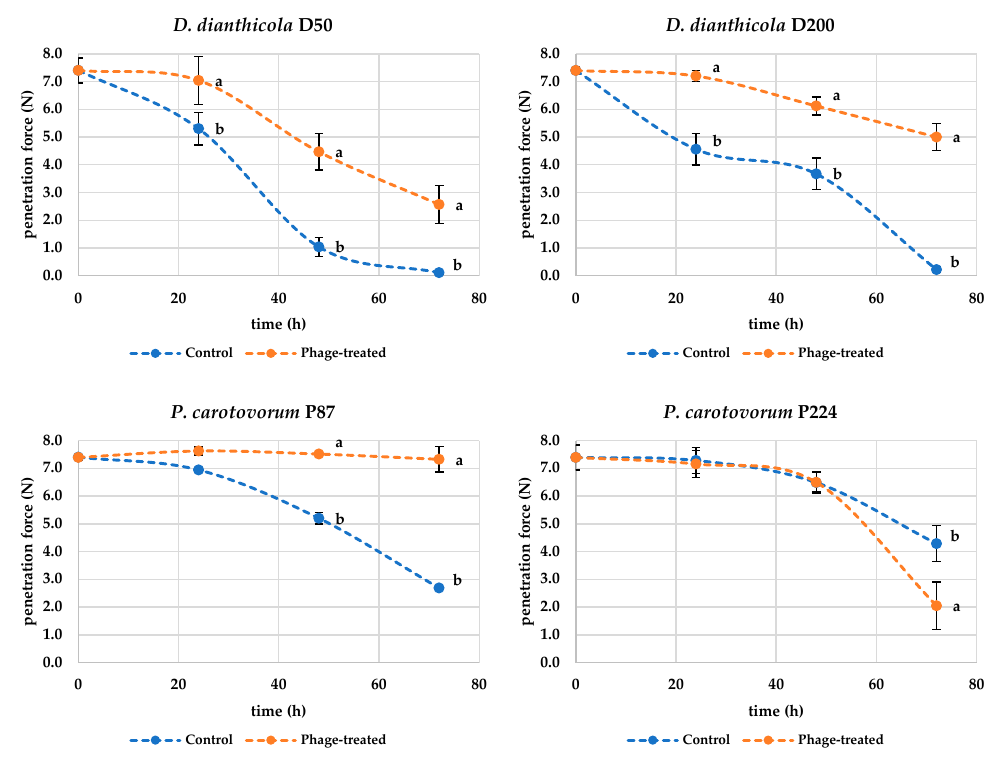
Figure 5. Change in penetrating force (N) during storage of control (inoculated by bacteria) and phage-treated cylinder cuts ( n = 12); markers represent the means, and the error bars represent the standard deviations; means with different lowercase letters (a or b) are significantly different between the control and phage-treated samples ( p < 0.05). Table 1. Potato cylindrical cut color (Mean ± SD) during storage at 25 °C and values of the color change coefficient Δ E.